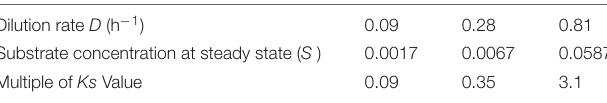
TABLE 2 | Steady-state substrate concentration ( S, arbitrary units) derived from the Novick-Szilard model (arbitrary unit = concentration of the original TSB medium).